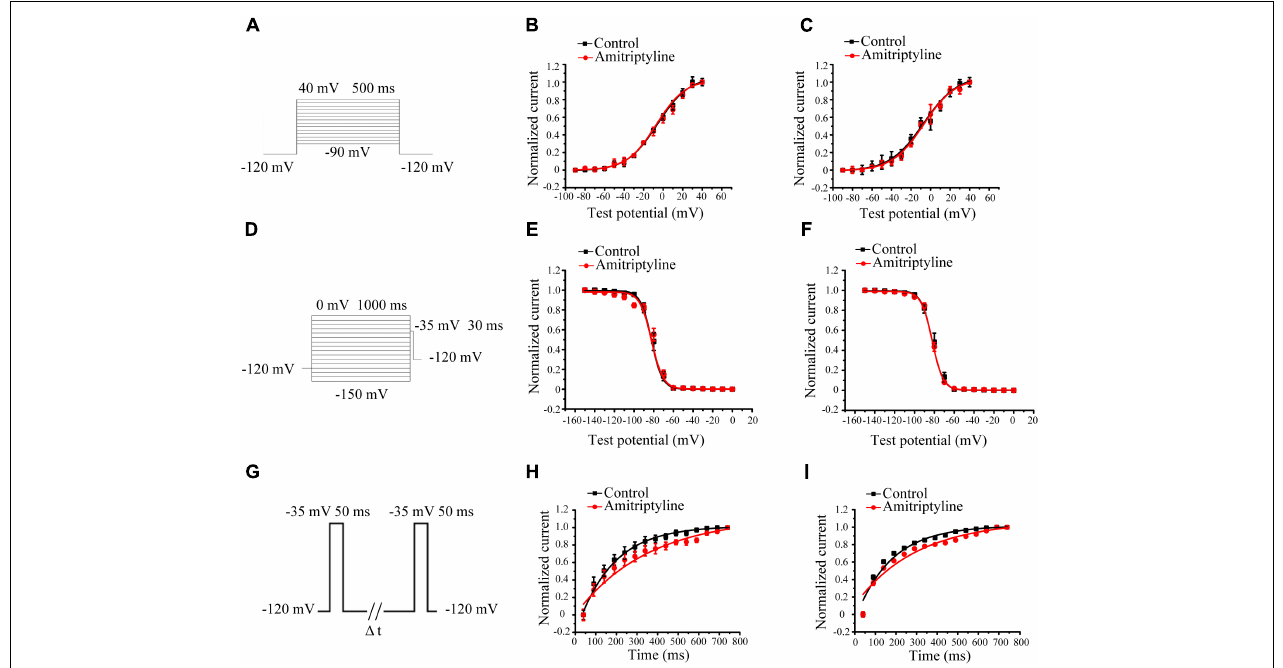
FIGURE 2 | Effect of amitriptyline on the gating properties of Nav1.5 currents. (A) Protocols for steady-state activation (SSA) recording. (B) SSA curves for the acute effect of amitriptyline. (C) SSA cures for the long-term effect of amitriptyline. (D) Protocols for steady-state inactivation (SSI) recording. (E) SSI curves for the acute effect of amitriptyline. (F) SSI curves for the long-term effect of amitriptyline. (G) Protocols for recovery from inactivation (RFI) recording. (H) RFI curves for the acute effect of amitriptyline. (I) RFI curves for the long-term effect of amitriptyline.